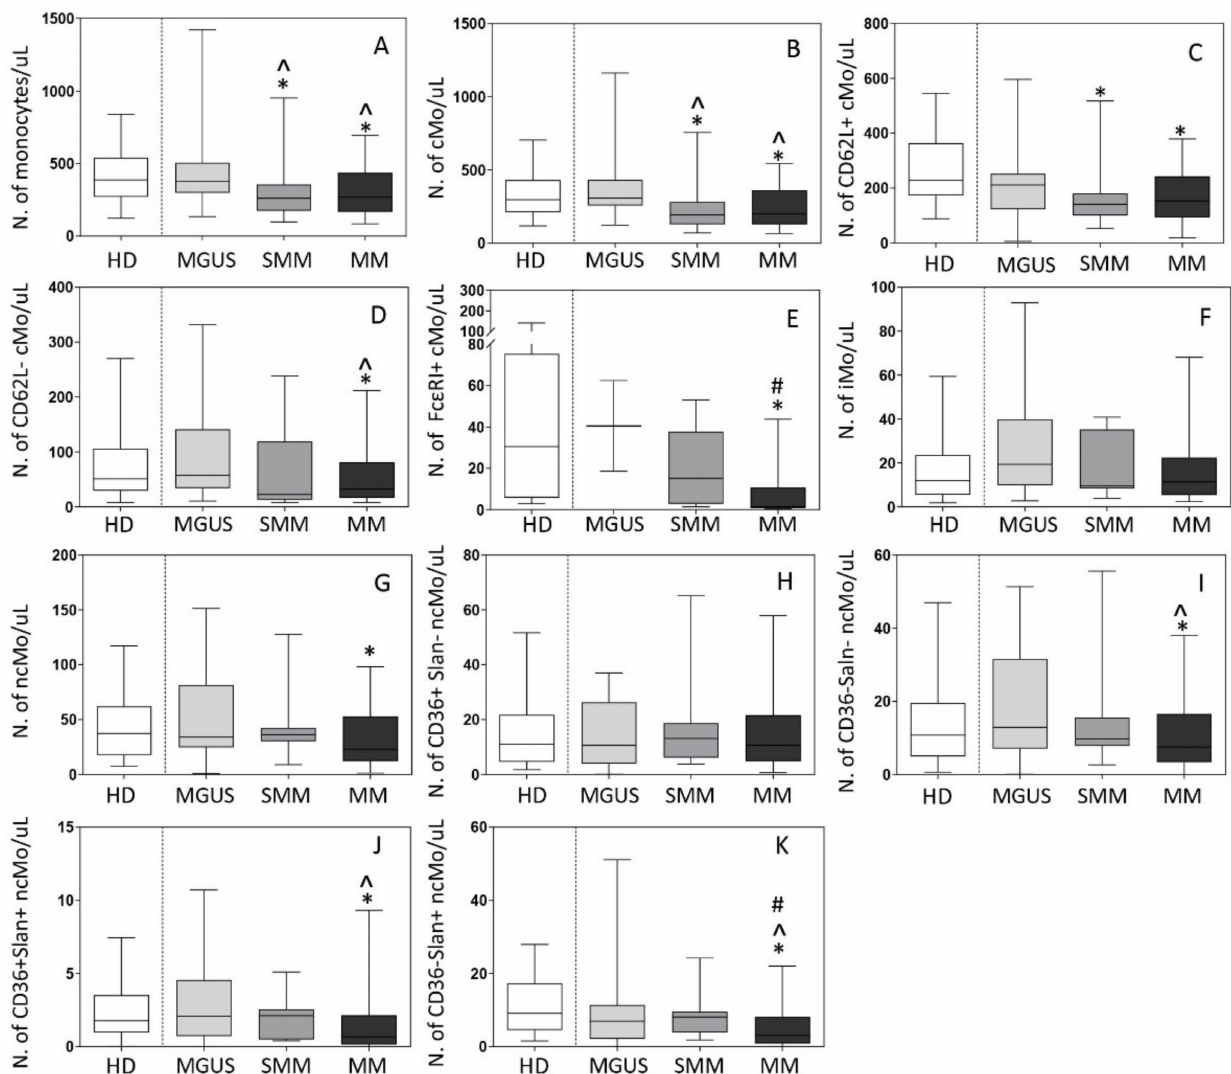
Figure 3. Distribution of total monocytes (Mo) (panel A ) and monocyte subsets (panels B – K ) in blood of newly-diagnosed MGUS ( n = 22), SMM ( n = 13) and MM ( n = 88) patients vs. age-matched HD ( n = 97). In (panels A – K ), notched boxes extend from the 25th to the 75th percentile values; the lines in the middle and vertical lines correspond to median values and the 5th and 95th percentiles, respectively. Statistical significant differences ( p ≤ 0.05) were observed vs. * HD, ˆ MGUS, and # SMM patients after applying the Mann–Whitney non-parametric test (as the KS normality test showed that data for these variables did not follow a normal distribution). cMo: classical monocytes; iMo: intermediate monocytes; ncMo: non-classical monocytes; HD: healthy donor; MGUS: monoclonal gammopathy of undetermined significance; SMM: smoldering multiple myeloma; MM: multiple